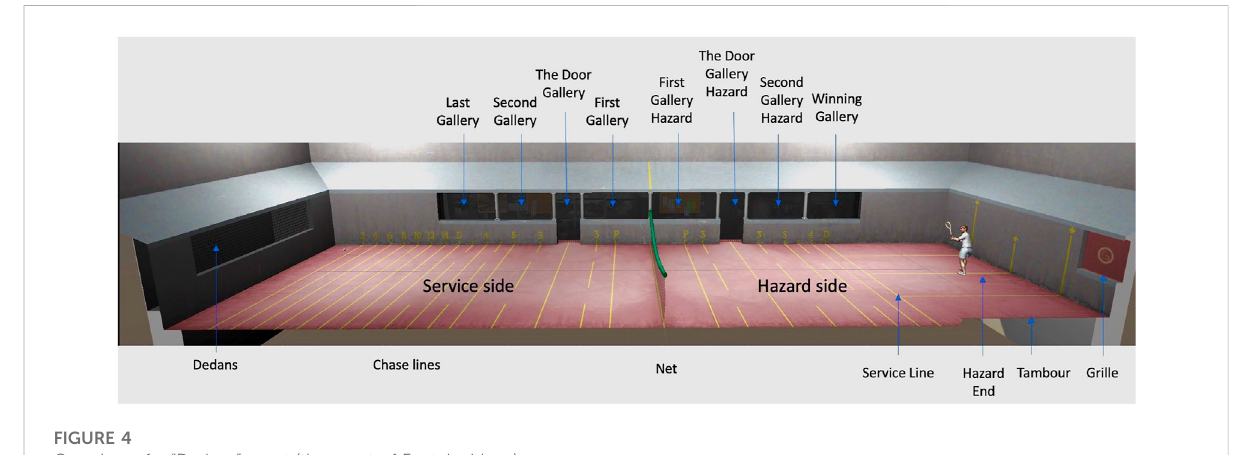
FIGURE 4 Overview of a “ Dedans ” court (the court of